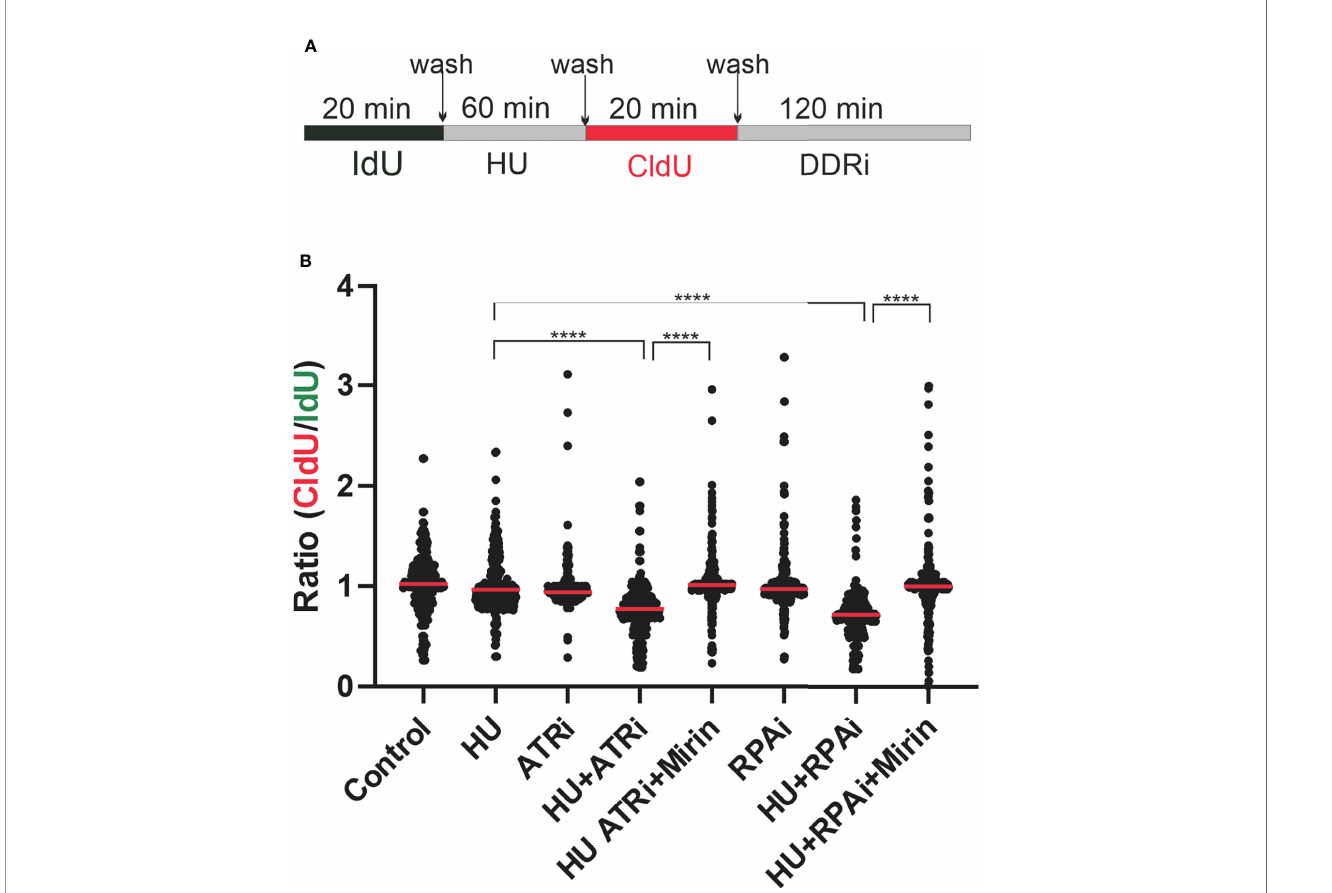
FIGURE 5 | Replication protein A inhibitor (RPAi) impact on replication fork dynamics. (A) Schematic depiction of experimental design. DNA was pulse-labeled with IdU for 20 min. After IdU removal, replication forks were stalled by the addition of HU or left to replicate with vehicle treatment. HU was removed, and replication was labeled with CldU. Following CldU, cells were treated with the DDRi or vehicle. (B) Quanti fi cation of results from DNA fi ber analysis in H460 cells treated with the indicated agents. HU was used at a fi nal concentration of 2.5 mM, the ATRi VE-822 at 2 µM, and the RPAi 329 at 50 µM. Data presented are combined from three individual experiments (100 fi bers analyzed per experiment; 300 fi bers total). Red bar indicates the median value of CldU/IdU. Data were analyzed by ANOVA with Bonferroni test for multiple comparisons (****p <